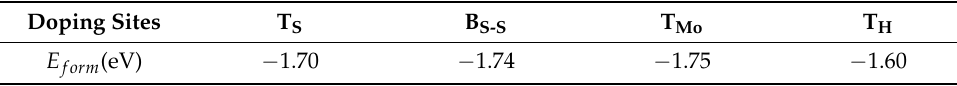
Table 2. Formation energy of the four Ga-doping models.